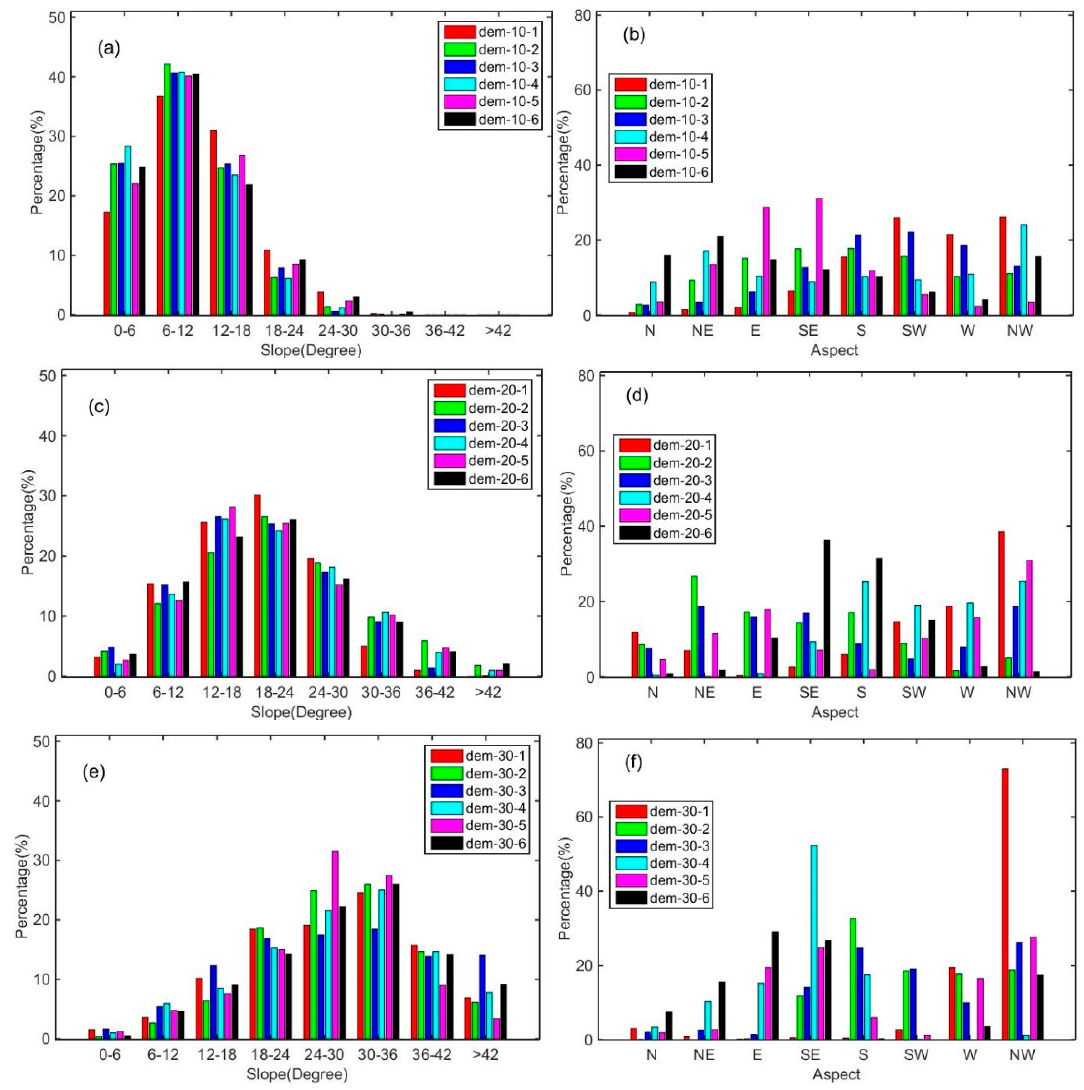
Figure 3. Distributions of slope ( a , c , e ) and aspect ( b , d , f ) within a 1-km pixel under real DEMs with different mean slopes: ( a , b ) 10°; ( c , d ) 20°; and ( e , f ) 30°. In the legends of ( b , d , f ), N, NE, E, SE, S, SW, W and NW stand for north, northwest, east, southeast, south, southwest, west and northwest, respectively. In the north, the SAA is 0°. The SAA gradually increases in a clockwise rotation of the determined direction, until the SAA is 360° (i.e., when the SAA rotated back to its original north position).